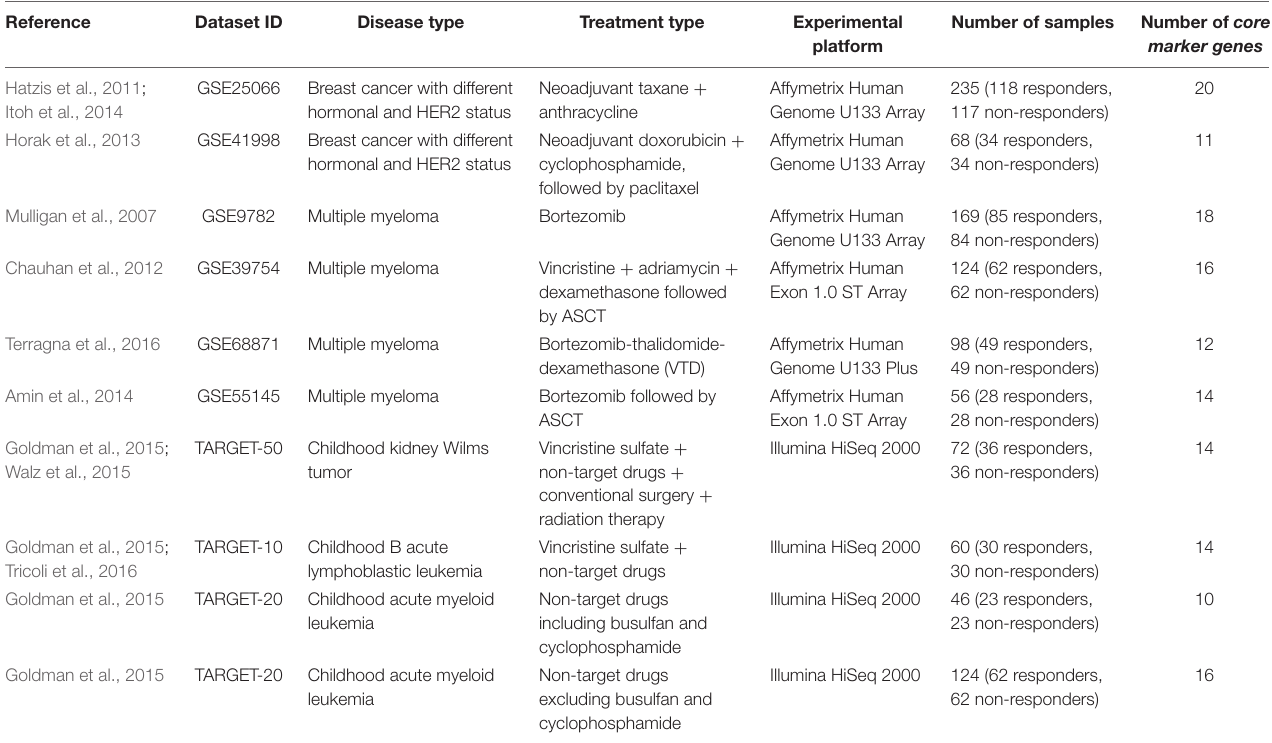
TABLE 1 | Clinically annotated gene expression